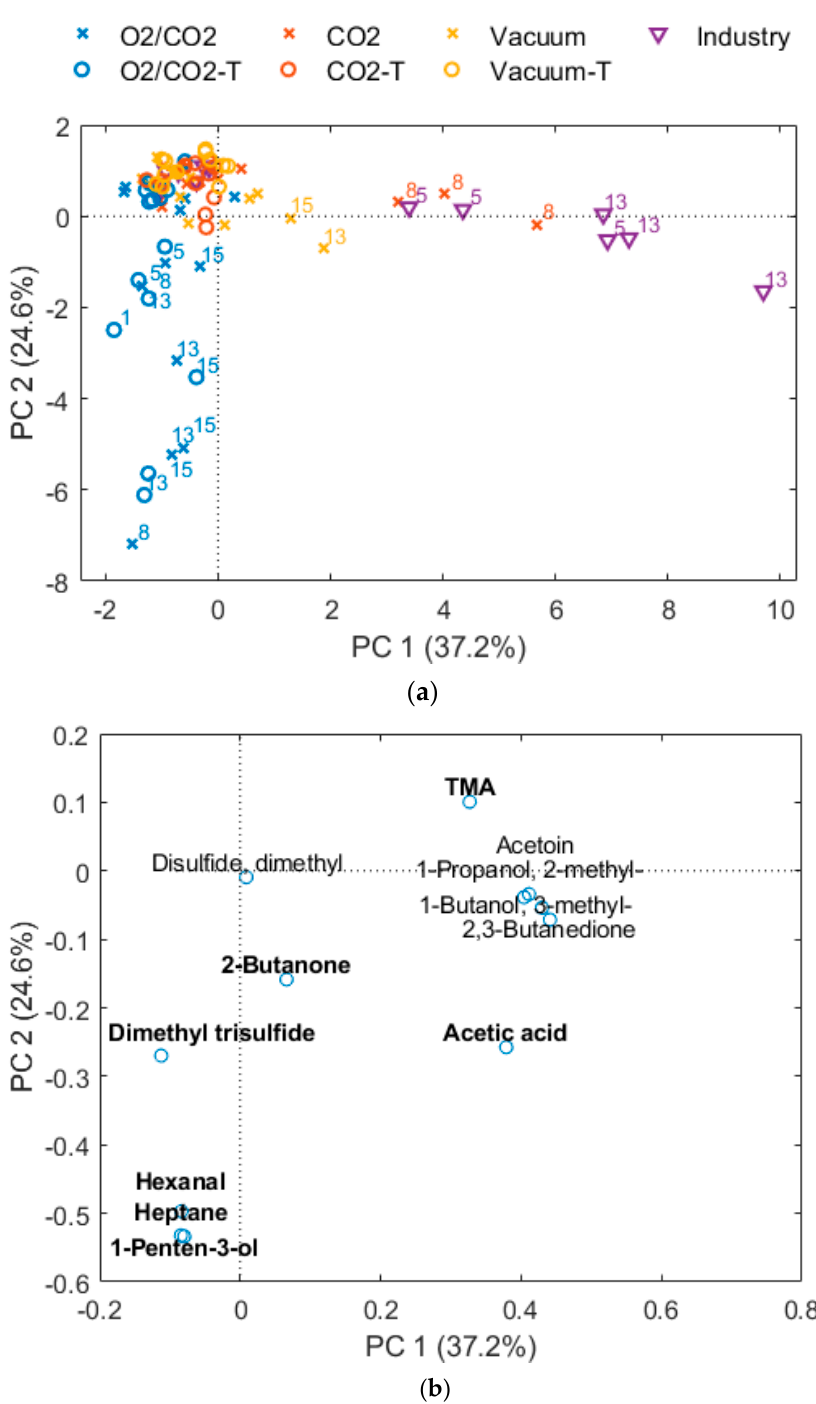
Figure 6. PCA of volatile components after 8 and 13 days of storage for fresh (cross symbol) and thawed (circle symbol) samples, Table 2. samples (red color) are packaged with 60% CO 2 , 40% N 2 and a CO 2 emitter, and “O 2 /CO 2 ” (blue color) is packaged with 60% CO 2 and 40% O 2 . “Industry” samples (purple triangle symbol) and “Vacuum” samples (yellow color) are packaged with vacuum. ( a ) Score plot and ( b ) loading plot. Days of storage are indicated by label for those with score PC1 > 1 or score PC2 < 1. Loading plot: Compounds with significant effect of packaging gas (FDR < 0.05) from the 5050 manova/rotation test for design samples are in bold letters.